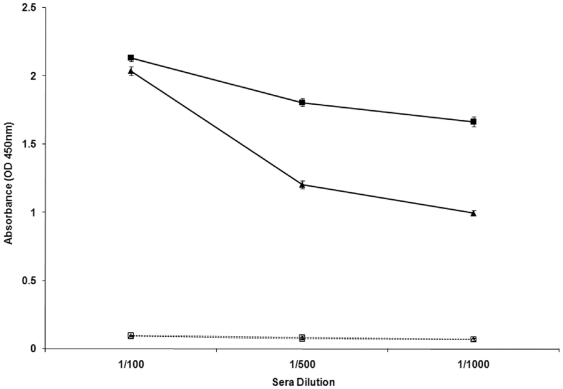
Screening of OmpA-specific IgG in immunised BALB/c mice.Mice were immunised with 50 µg of recombinant Omp3 or Omp7. The sera were collected (n = 4) prior to and after immunisation and pooled. The levels of OmpA-specific IgG were analysed by ELISA. The presence of specific antibodies to recombinant Omp3 (closed triangles) and Omp7 (closed squares) proteins was observed in sera from immunised mice but not in pre-immunised sera (open triangles for Omp3 pre-immunised sera and open squares for Omp7 pre-immunised sera) (P<0.05). Data represent the mean absorbance (OD450nm)±SEM.